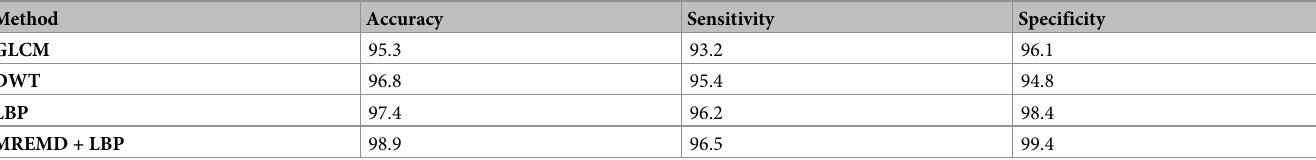
Table 2. Comparison of different features extraction methods.